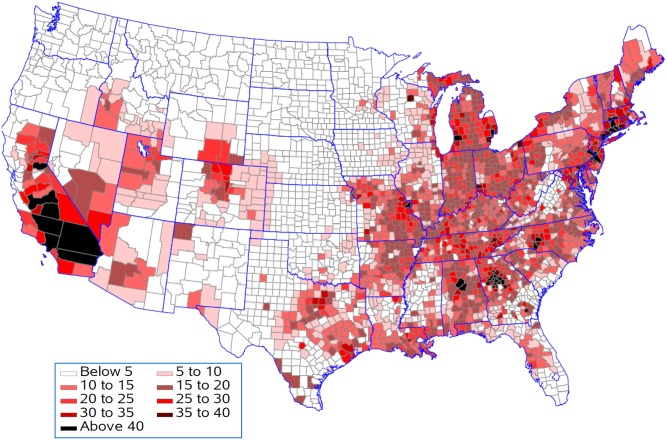
Increase in death from death from all causes (per 100,000 population per year) resulting from being above the national 25th percentile for each pollutant.